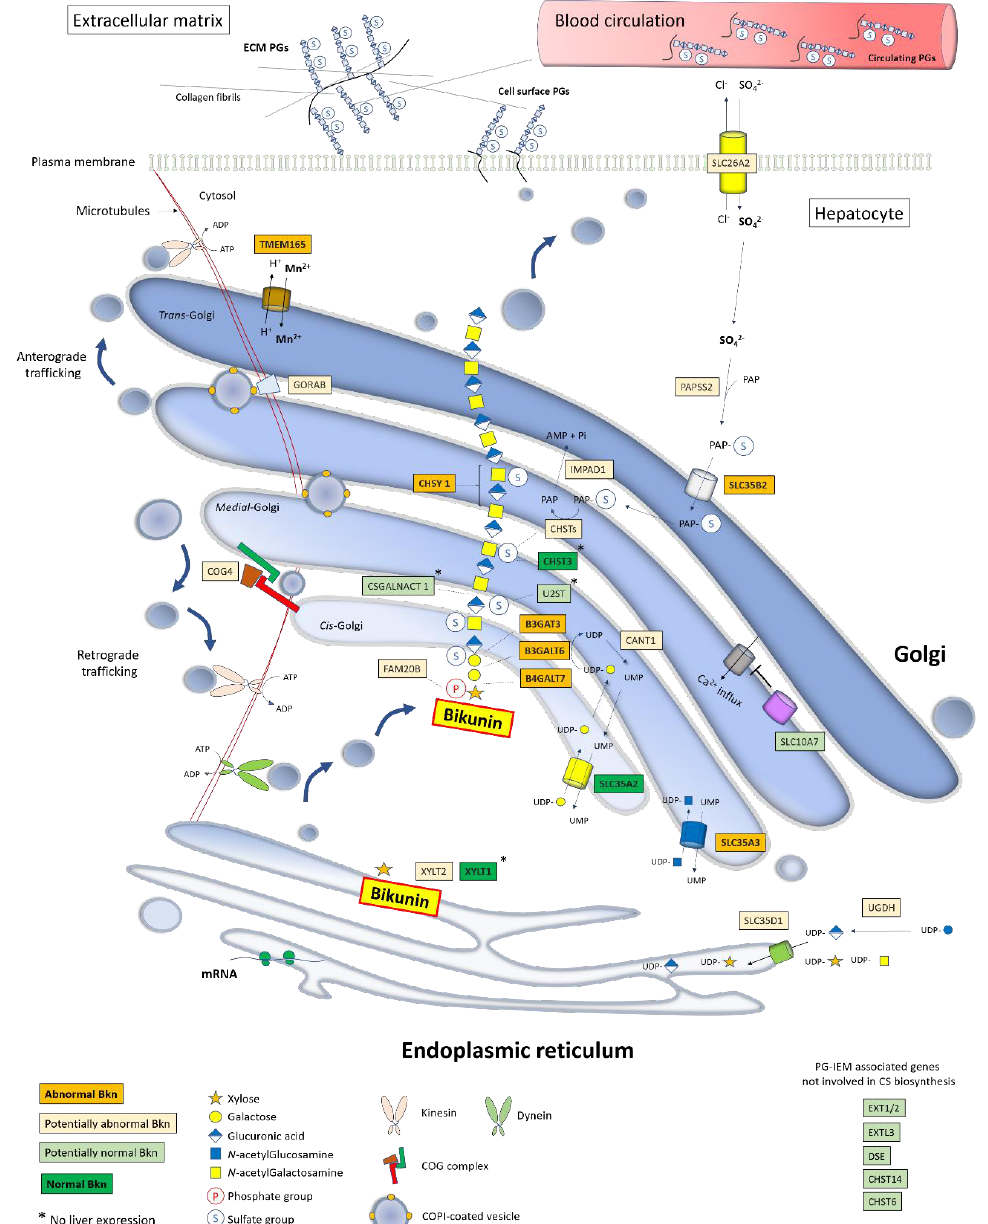
Figure 5. Schematic view of Bkn – CS biosynthesis into the secretory pathway and impact of PG-IMD gene deficiencies on Bkn analysis profile. The function of each PG-IMD-associated gene is depicted together with the Bkn – CS elongation, modifications, and sorting within the secretory pathway in hepatocytes. The latter include an ER-to-Golgi anterograde vesicular flow along microtubules as ensured by dynein molecular motors while retrograde trafficking within the Golgi involves tethering factors (COG complex) and Rab-GTPase-associated proteins such as GORAB. Additionally, retrograde transport to the ER involves kinesins. Golgi homeostasis is maintained by ionic equilibrium (H + , Na + , Mn 2+ , Ca 2+ ) involving ion transporters such as TMEM165. UDP-sugars and PAPS are synthesized in the cytosol by specific enzymes and their uptake within the ER/Golgi lumen is ensured by nucleotide sugar transporters and PAPS transporters, respectively. Nascent PGs are sorted in the TGN and packed into cargo vesicles addressed through kinesin-dependent post-Golgi traffic to the plasma membrane and then to the ECM and/or to blood after exocytosis. Deficiencies in the highlighted genes lead to PG-IMD syndromes, the screening of which could benefit from serum Bkn analysis. Deep and light orange boxes represent gene deficiencies leading to abnormal (already investigated) and potentially abnormal (not yet investigated) Bkn – CS biosynthesis, respectively. Deep and light green boxes include genes whose deficiency results in normal (already investigated) and potentially normal (not yet investigated) Bkn profiles, respectively.